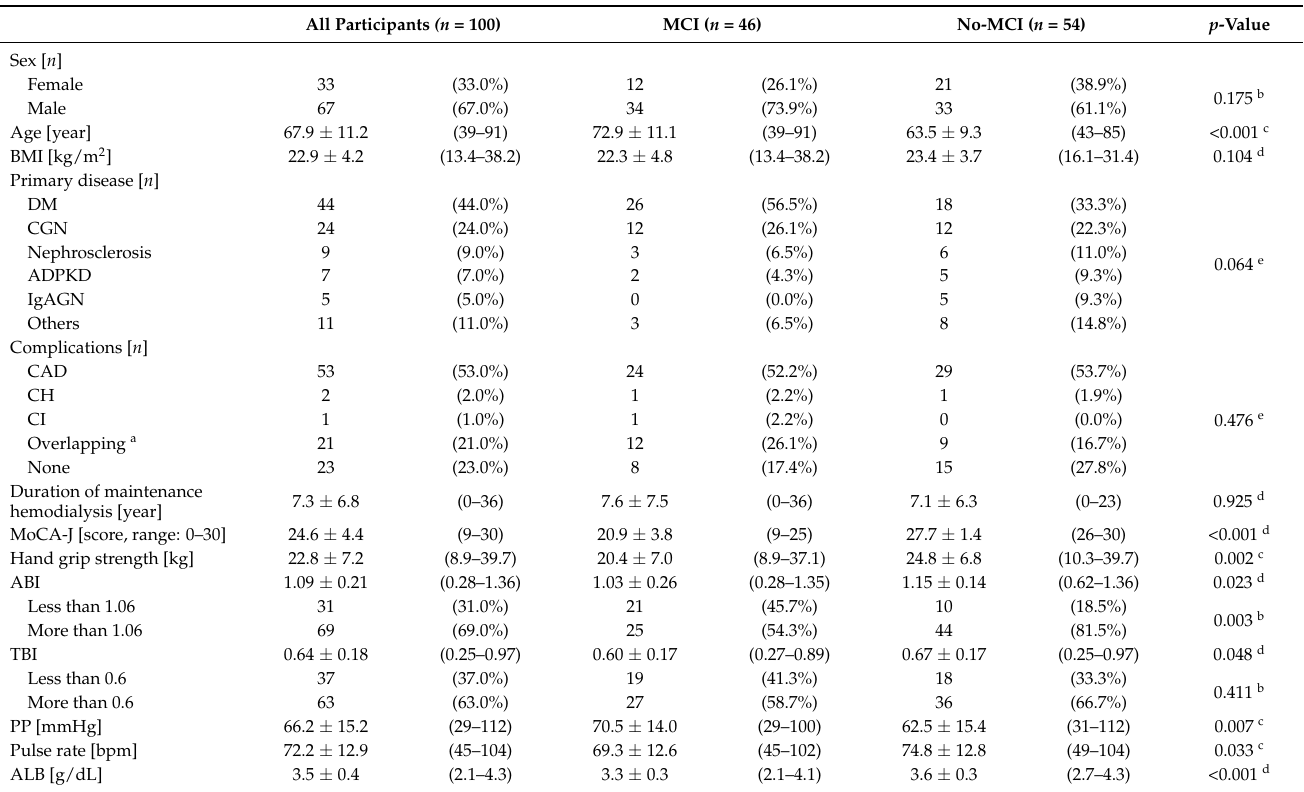
Table 1. Characteristics of the